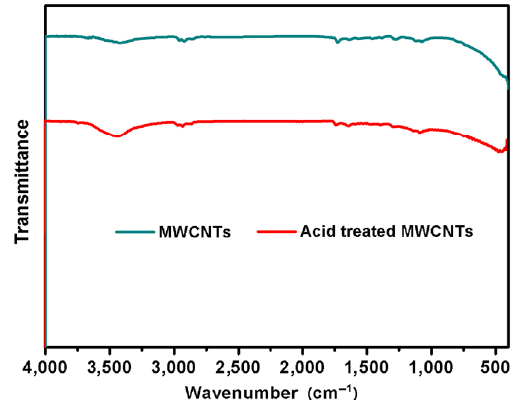
Fig. 1 Infrared spectra of the MWCNTs and mixed acid treated MWCNTs.